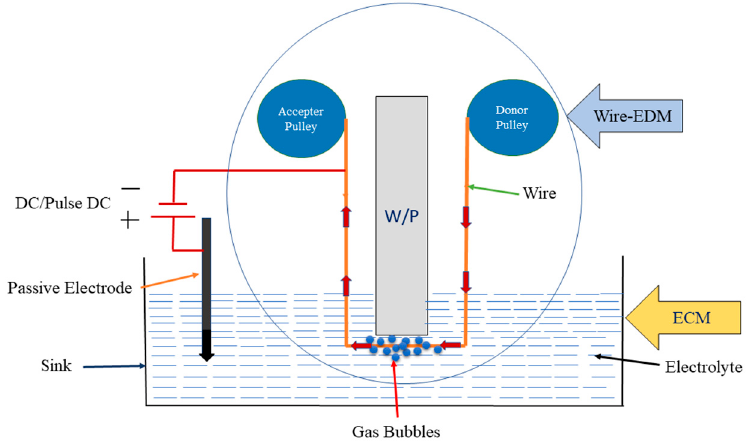
Figure 1. The TW-ECDM process [20].